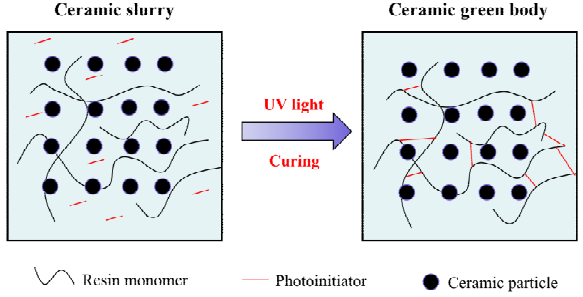
Fig. 23 Curing mechanism during stereolithography of